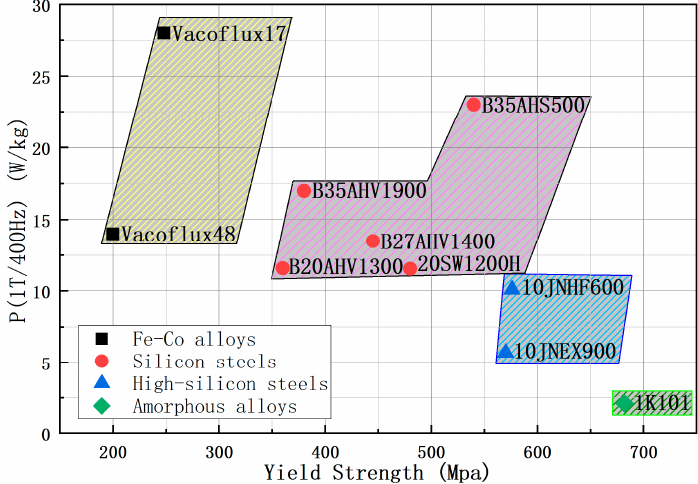
Figure 1. Comparison of yield strength and core loss for different silicon steels.